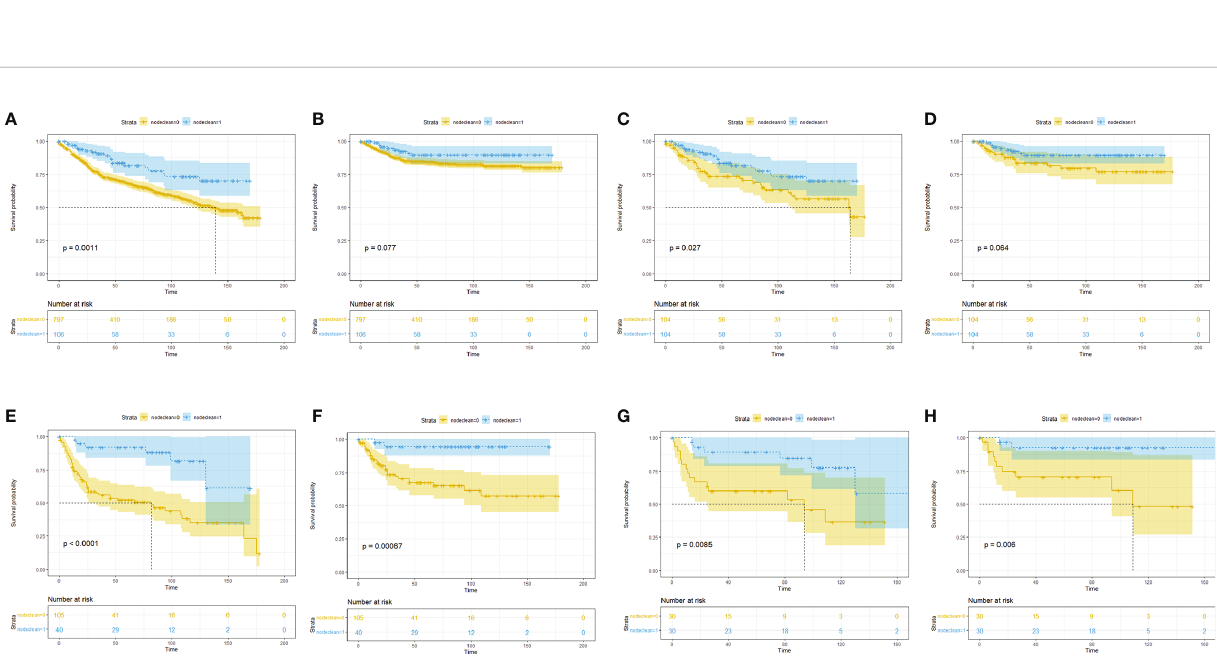
FIGURE 2 | Subgroup Kaplan – Meier survival analysis for LND. (A) Overall survival in the T1T2 subgroup based on the full cohort. (B) Cancer-speci fi c survival in the T1T2 subgroup based on the full cohort. (C) Overall survival in the T1T2 subgroup based on the PSM cohort. (D) Cancer-speci fi c survival in the T1T2 subgroup based on the PSM cohort. (E) Overall survival in the T3T4 subgroup based on the full cohort. (F) Cancer-speci fi c survival in the T3T4 subgroup based on the full cohort. (G) Overall survival in the T3T4 subgroup based on the PSM cohort. (H) Cancer-speci fi c survival in the T3T4 subgroup based on the PSM